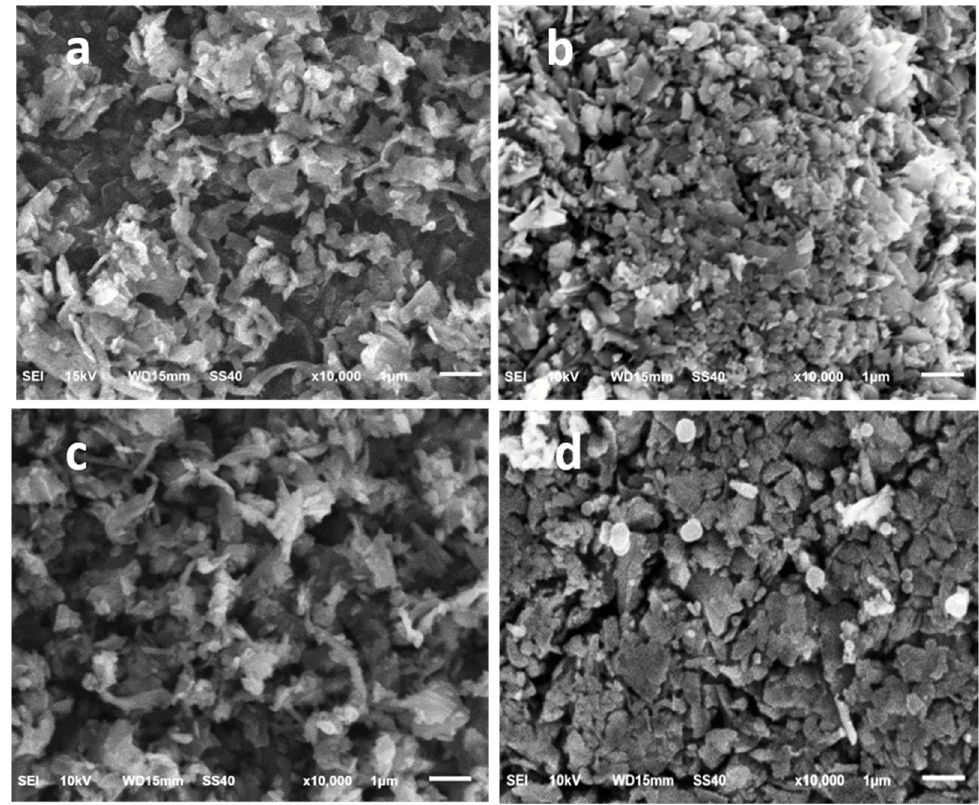
Figure 6. SEM images of ( a ) silicon flakes, ( b ) silicon flakes with an RF carbon coating, ( c ) silicon flakes with a layer of SiC and nanocarbon (5 h-process), and ( d ) silicon flakes with a layer of SiC and nanocarbon (5-h process) followed by the coating of a layer of RF carbon.